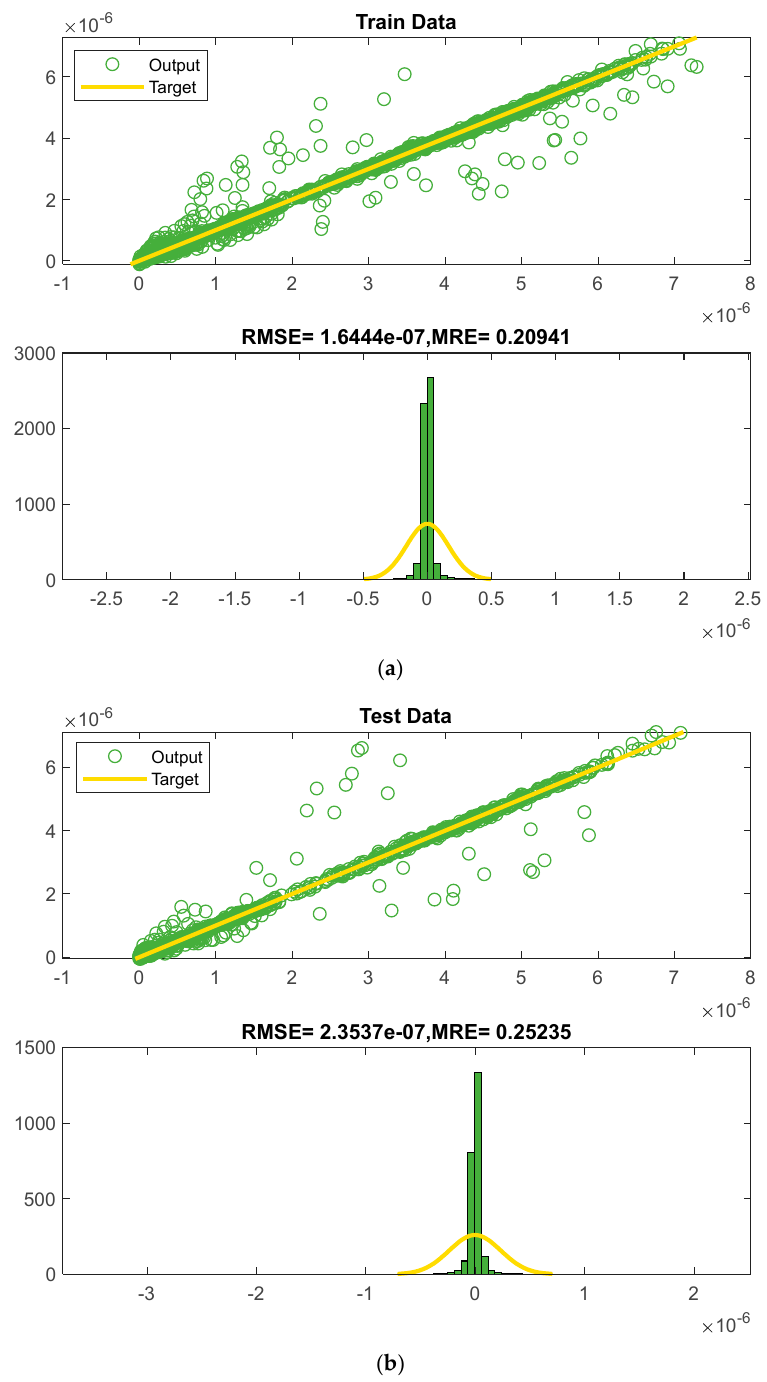
Figure 6. Diagram of the regression and error histograms for the: ( a ) training and ( b ) test datasets.